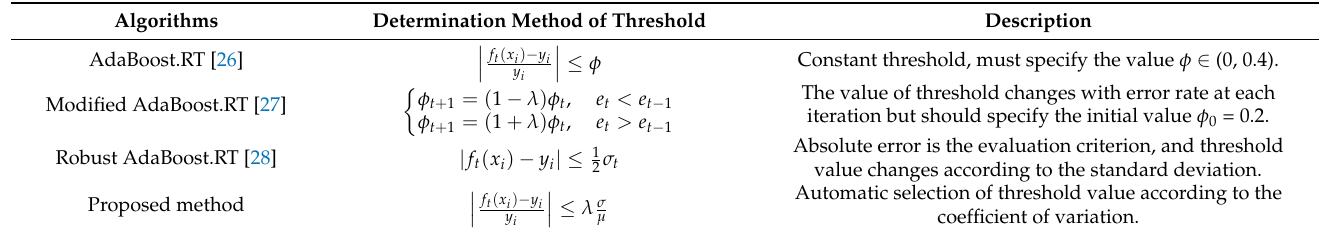
Table 2. Comparison of the threshold determination methods in different AdaBoost.RT algorithms.